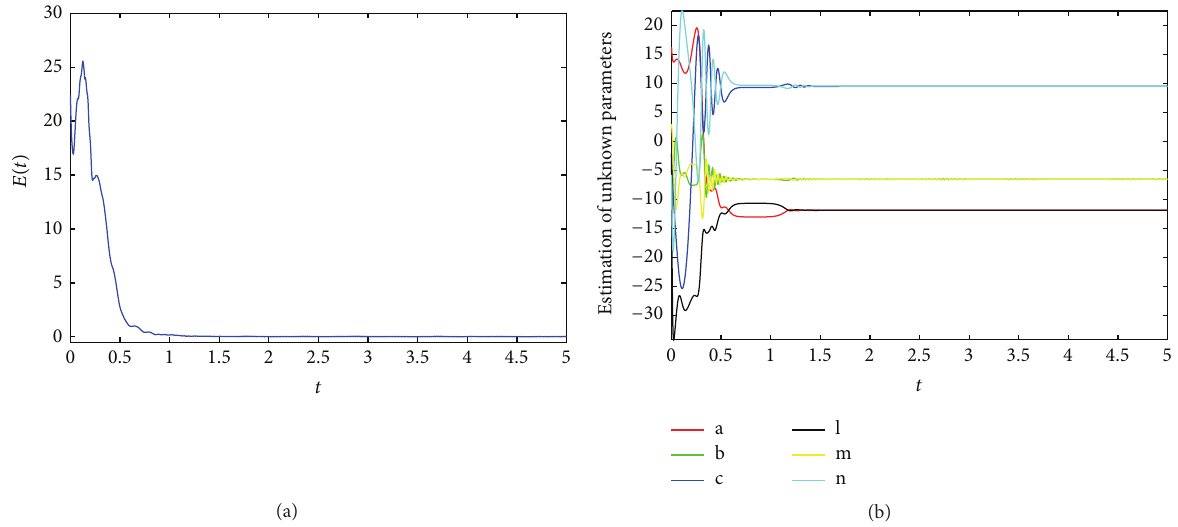
Figure 3: (a) Synchronization error between the drive and response networks composed of identical node dynamics; (b) estimation of unknown parameters in the drive and response networks. Here, the node dynamics is Lorenz system, and the functional relations are y 𝑖 = x 𝑖 .